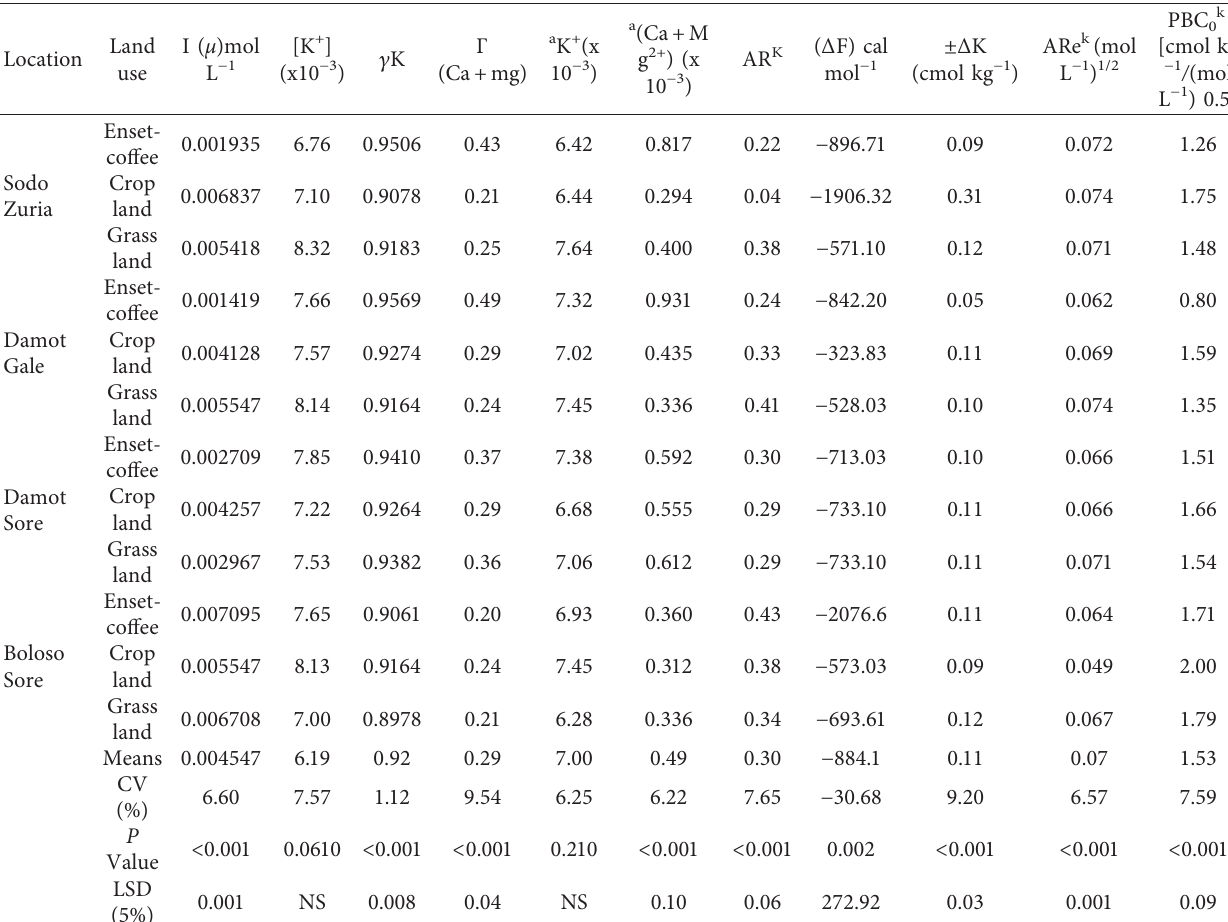
Table 4: Thermodynamic parameters of the soils as influenced by locations and land use